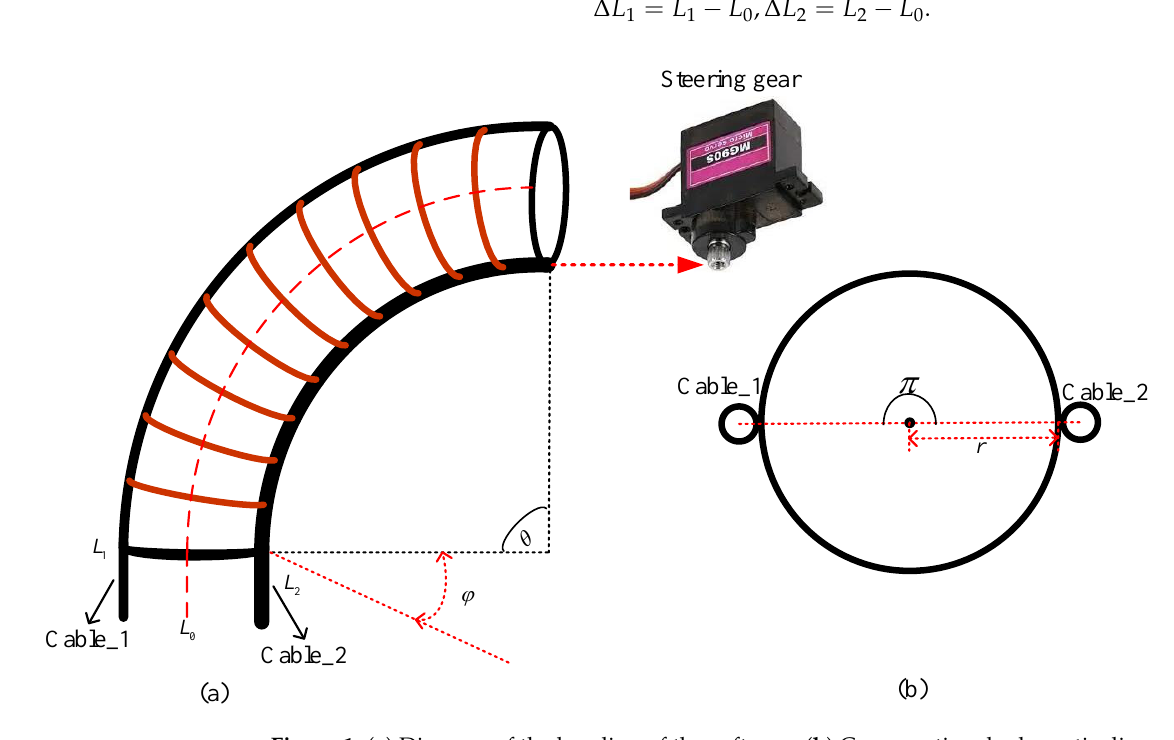
Figure 1. ( a ) Diagram of the bending of the soft arm; ( b ) Cross-sectional schematic diagram of the soft arm and the arrangement of the cable.